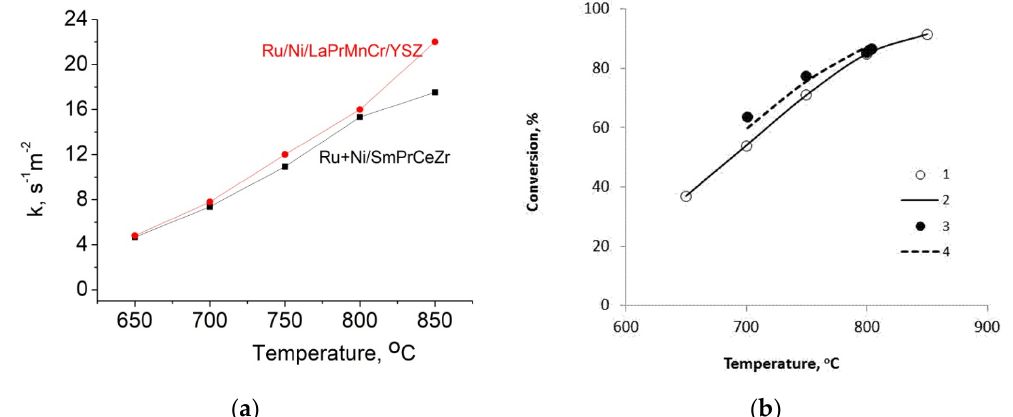
Figure 5. ( a ) Temperature dependence of specific rate constants for methane dry reforming on fractions of (Ru+Ni)/SmPrCeZrO and (Ru+Ni)/LaPrMnCr/YSZ catalysts. Feed 7% CH 4 + 7 % CO 2 , contact time 15 ms; ( b ) Temperature dependence of CH 4 conversion in CH 4 dry reforming on fraction of (Ru+Ni)/(LaPrMnCr+YSZ) catalyst (1, 2; feed 7 % CH 4 + 7 % CO 2 in He, contact time 15 ms) and on the stack of microchannel plates with this active component (3, 4; feed 20% CH 4 + 20% CO 2 in Ar, contact time 0.4 s). 1,3-experimental data, 2,4-fitting.